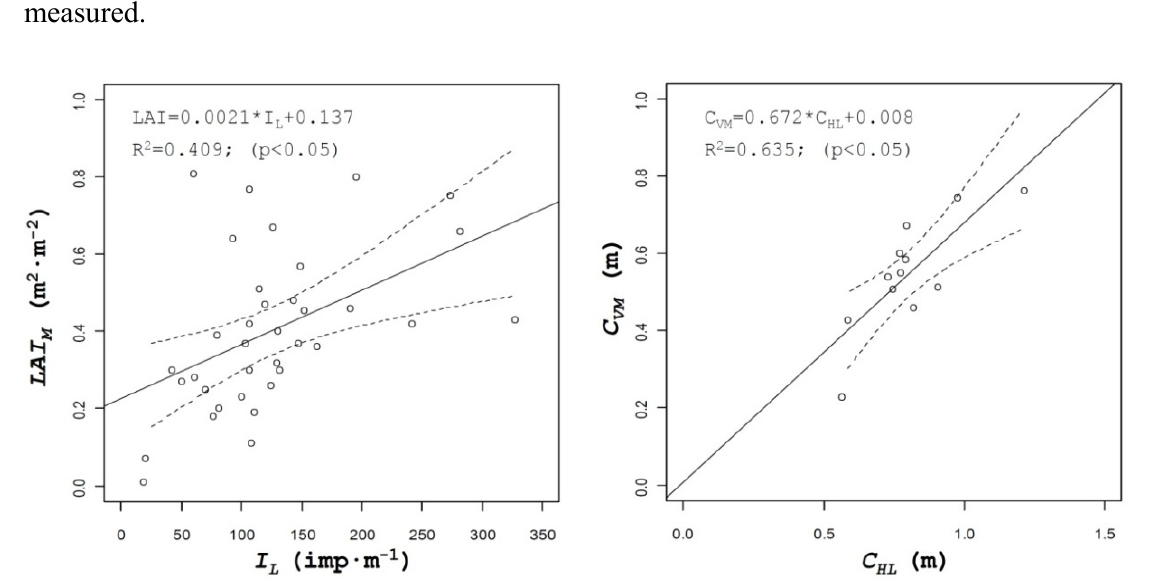
Figure 7. Relation between laser impact obtained with LIDAR and LAI (left). On the right correlation between canopy height calculated with LIDAR and canopy volume manually measured.